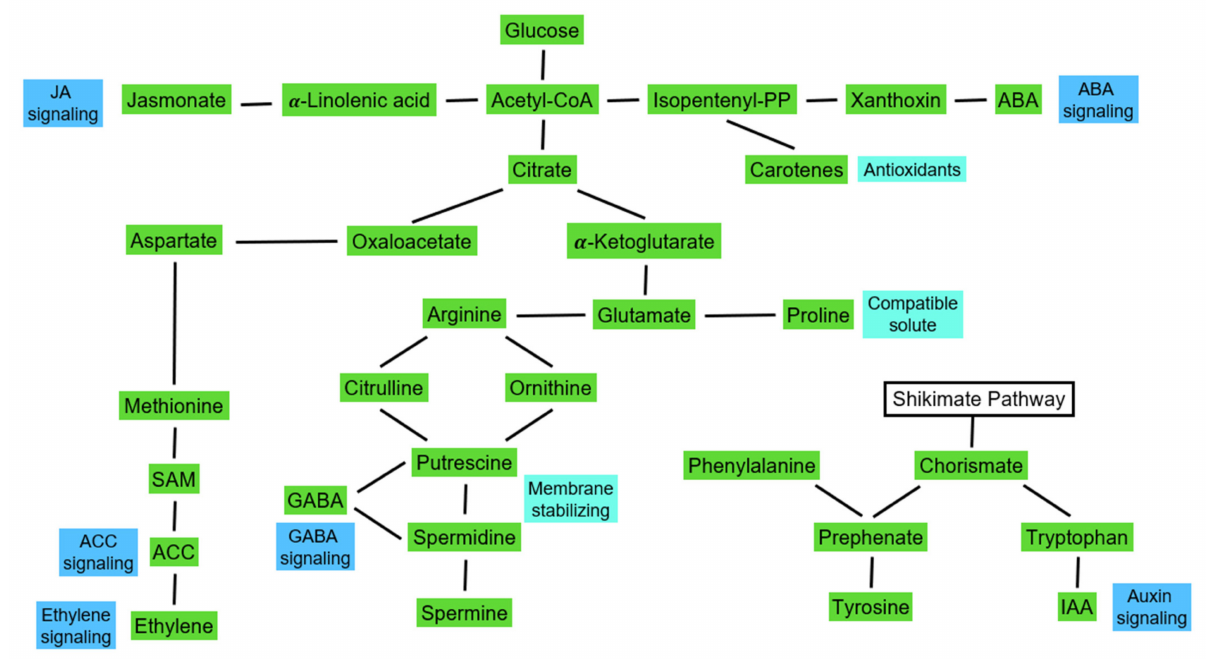
Figure 5. Linking messenger synthesis to primary metabolism. This figure provides a general overview of carbohydrate and amino acid metabolism. It indicates how the synthesis of plant hormones and beneficial compounds is linked to the house-keeping metabolism of